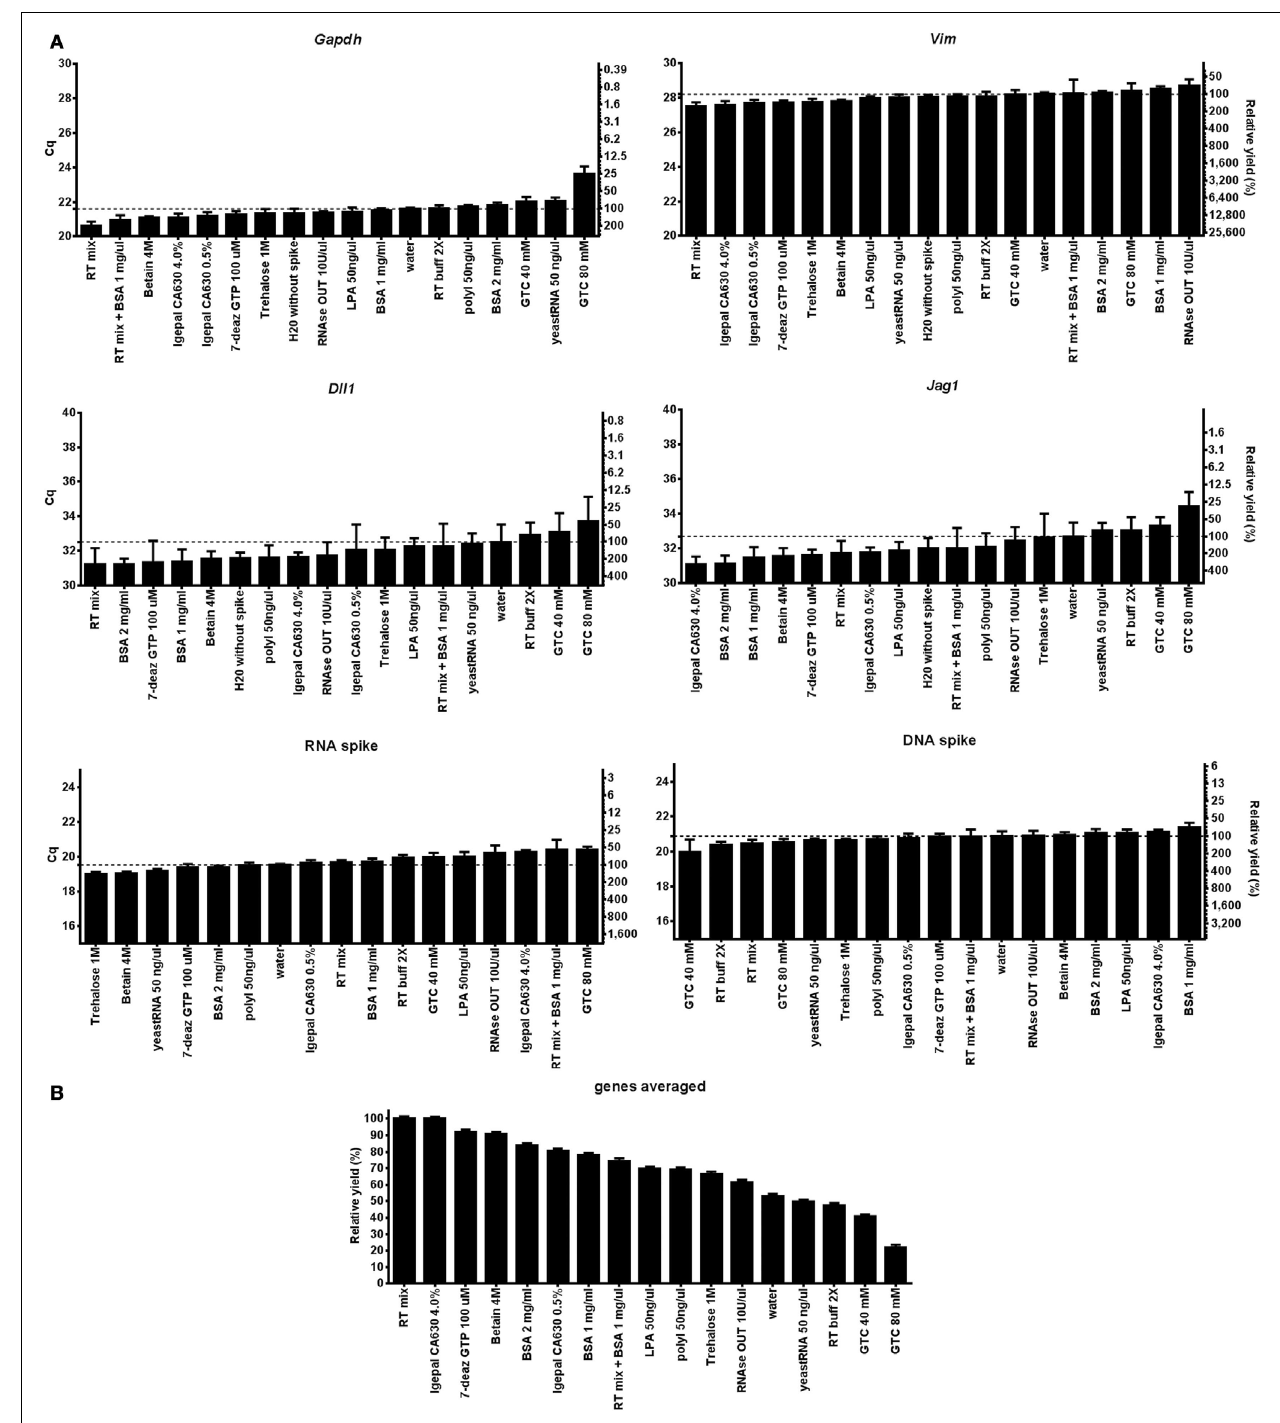
Data are shown as mean ± SD ( n = 4). Missing data were excluded and are shown inTable S4 in Supplementary Material. (B) Mean RT yield for Gapdh , Vim , Dll , and Jag1 .The relative transcript yield of each transcript was averaged and compared to the optimal RT-qPCR condition (RT mix). Data are shown as mean ± SD ( n = 4). 7-deaz GTP, 7-deaza-2 (cid:48) deoxyguanosine 5 (cid:48) triphosphate lithium salt; GTC, guanidine thiocyanate; LPA, linear polyacrylamide; polyI, polyinosinic acid potassium salt; 2 × RT buffer, 2 × reverse transcription buffer; RT mix, 2 × RT buffer, 5 µ M random hexamers, 5 µ M oligo-dT, and 1mM